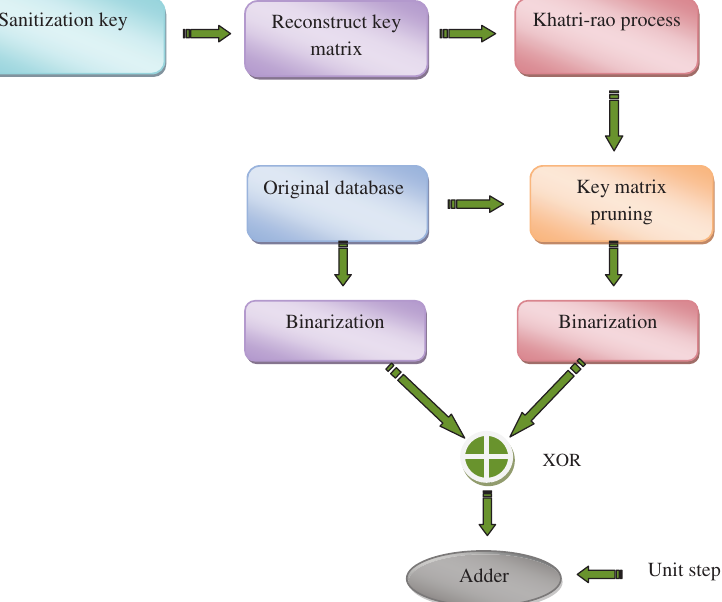
Figure 2: Sanitization Process of the Implemented Data Preservation